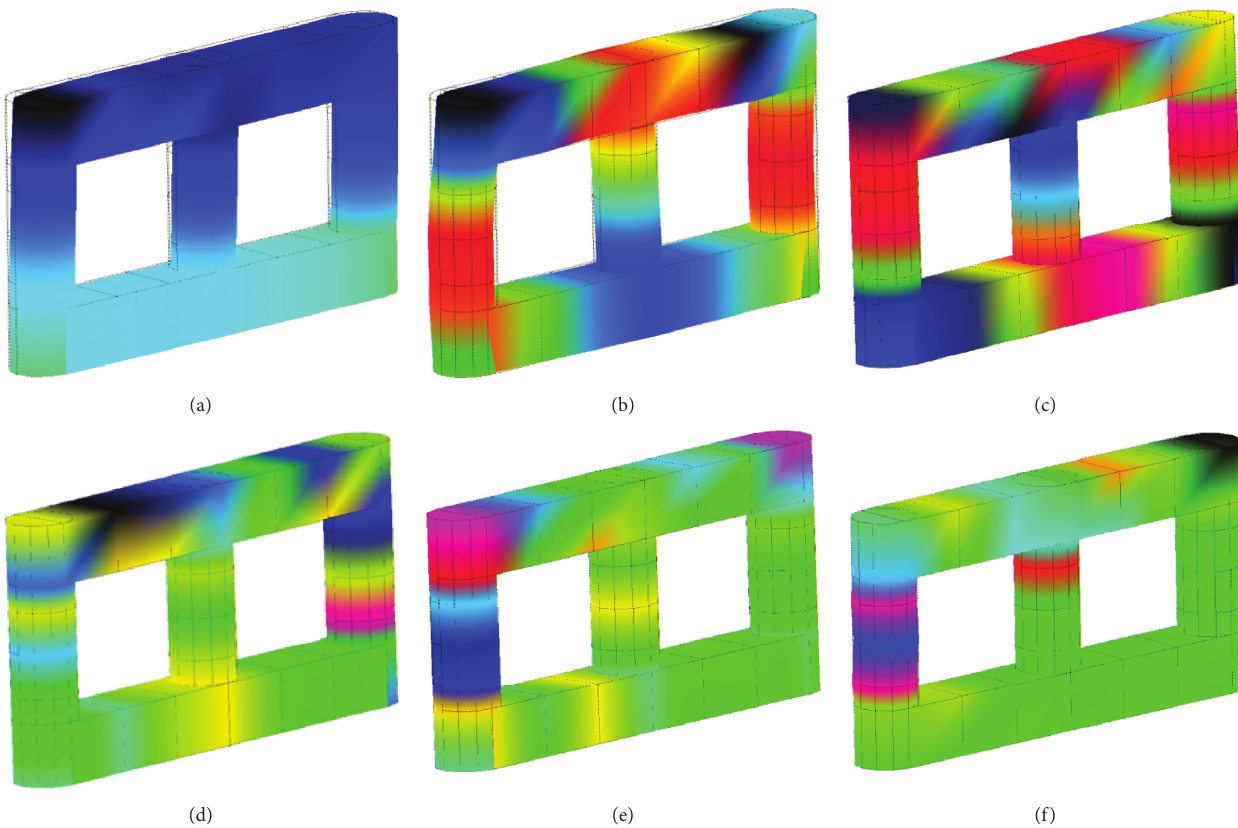
Figure 17: Test modal vibration modes of the transformer core. (a) First-order vibration mode. (b) Second-order vibration mode. (c) Third- order vibration mode. (d) Fourth-order vibration mode. (e) Fifth-order vibration mode. (f) Sixth-order vibration mode.